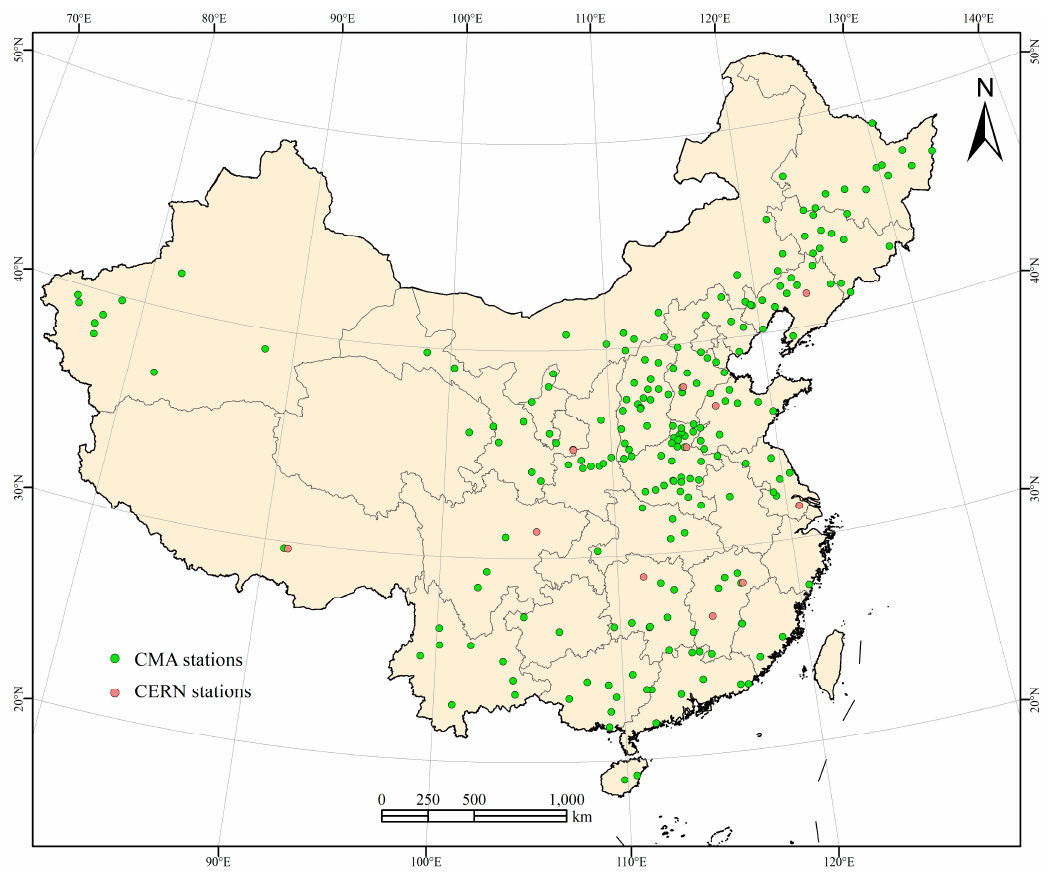
Figure 1. Location of the ground observation stations. Table 1. Number of available reference data for each crop.